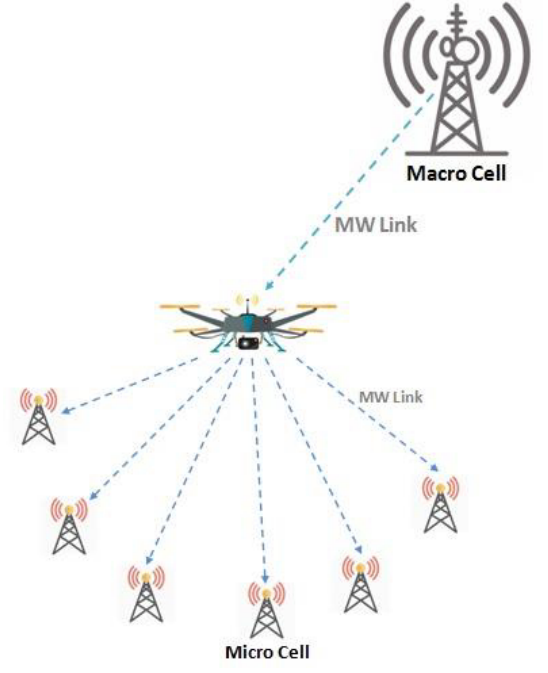
Fig 12. Macro cell to UAV to micro cell connectivity UAV Assisted Macro Cell to UE via UAV